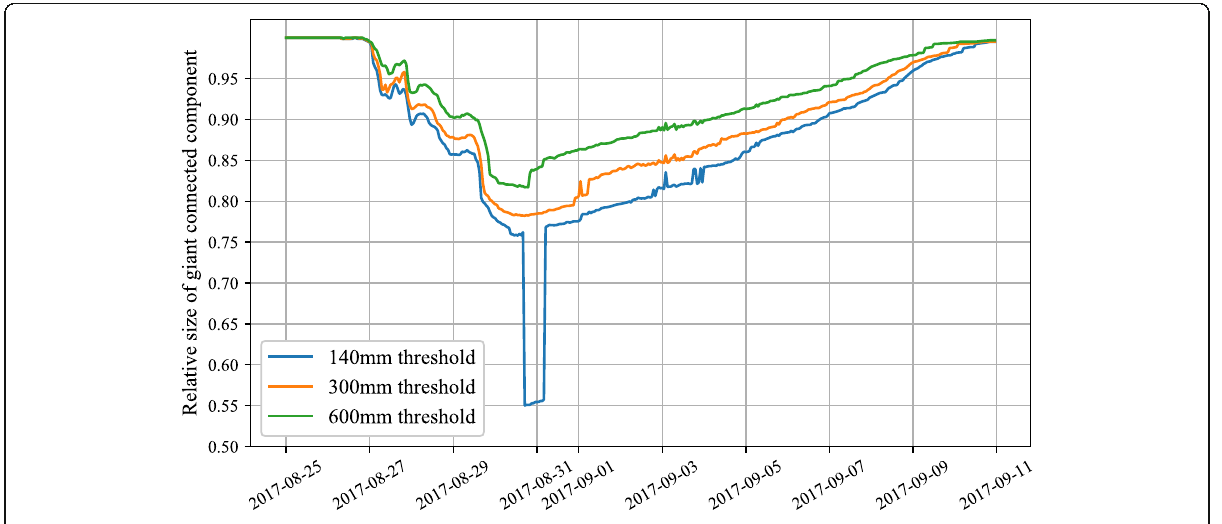
Fig. 5 Size of GCC in road network under different closure